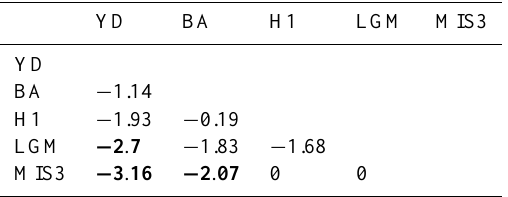
Table 2. Post hoc test (Mann–Whitney U) z values between the mean foraminiferal Mn / Ca (per individual) between climatic in- tervals. Significant differences are highlighted in bold.